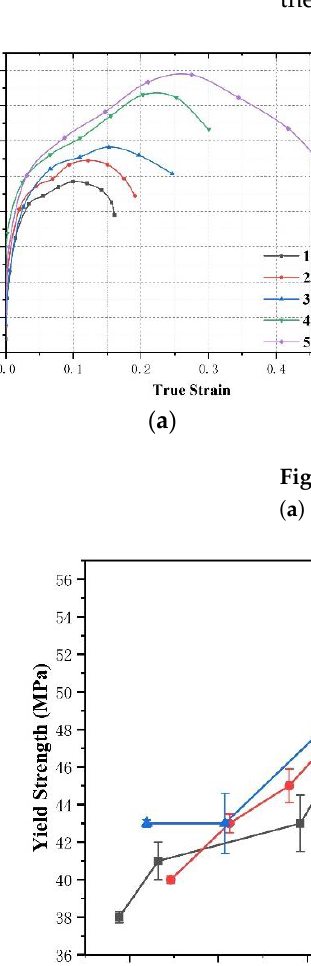
(16) Table 2. Mechanical parameters of PTFE/Cu composites at different strain rates. Sample No. Strain Rate (s − 1 )